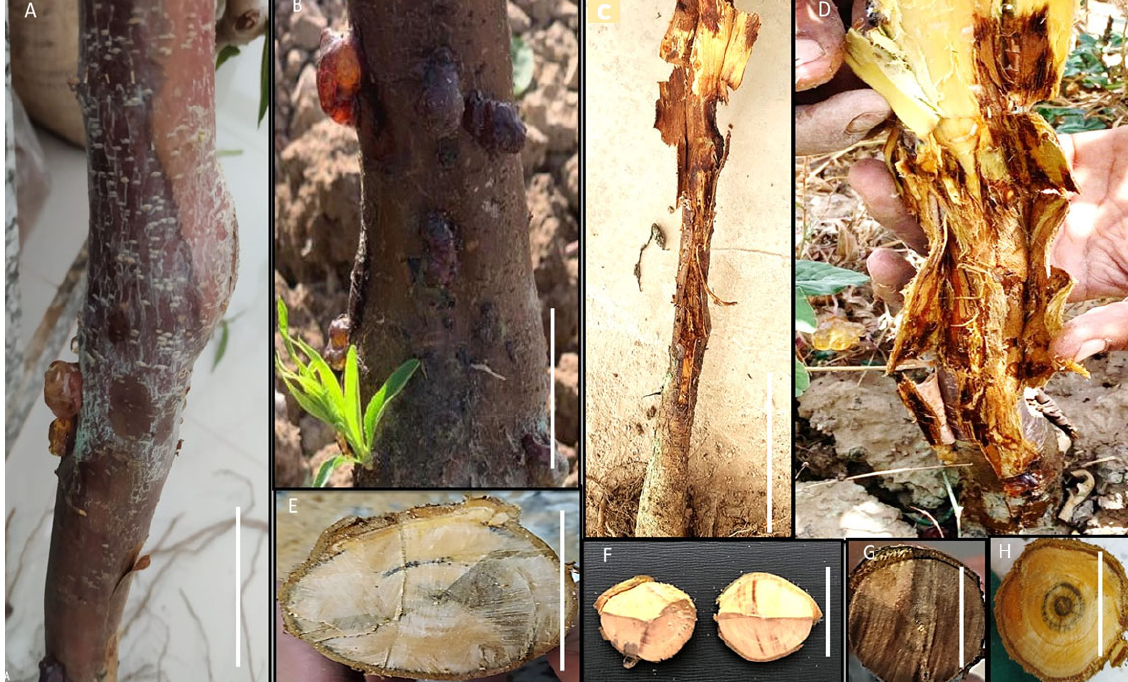
Figure 2. Symptoms of trunk diseases on almonds observed in the field. ( A ) Internal necrosis on the trunk caused by Lasiodiplodia theobromae . ( B ) Gummosis on the trunk caused by Fusarium ambrosium (as Neocosmospora ambrosia ), ( C , D ) Black spots and brown to black lesions of the xylem tissue, and ( E – G ) Transverse cuts showed sectorial necrosis and wood discoloration caused by ( E ) Curvularia hawaiiensis ; ( F ) Lasiodiplodia theobromae ; ( G ) Fusarium ambrosium . ( H ) Circular discoloration caused by Chondrostereum purpureum . Scale bars: ( A – C ) = 10 cm; ( E – H ) = 3 cm.